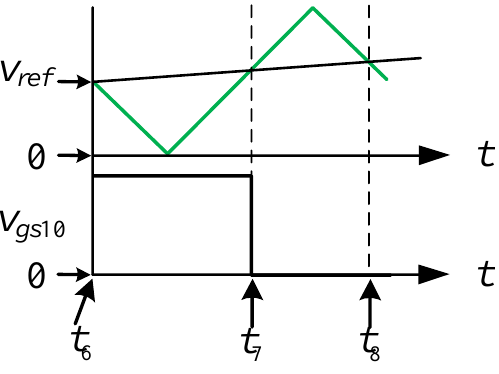
Figure 8. Gate signal of S 10 .